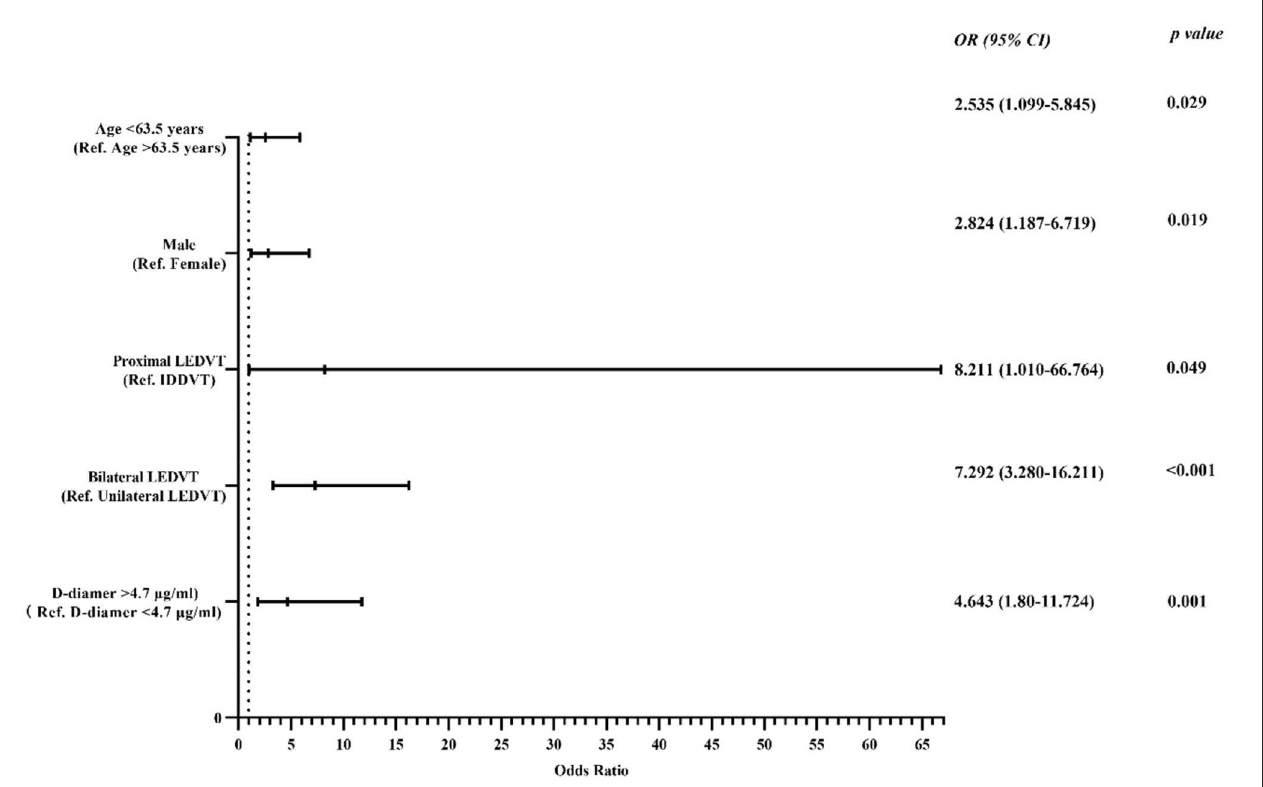
FIGURE3 Forest plot used to visualize the multivariate regression analysis of risk factors for IVCT in lower extremity DVT patients. IVCT, inferior vena cava thrombosis; LEDVT, lower extremity deep vein thrombosis; IDDVT, isolated distal deep vein thrombosis; Ref., reference.